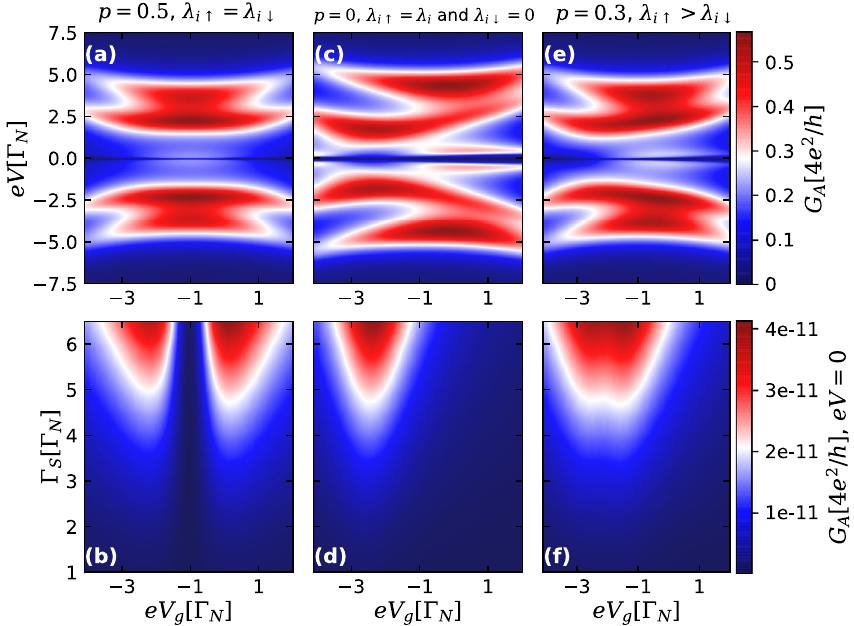
Figure 6. Upper panels: Color scale plots of the Andreev conductance G A [Eq. (5)] as a function of bias voltage 0.5 Ŵ , (cid:31) 2.0 Ŵ eV and QD gate voltage eV g , for the case of nonlocal MBSs ( (cid:31) R N L = N ) with small overlap = (cid:31) 3.0 Ŵ 0.5 , ( ε M R ) and Ŵ S = N . Panels ( a ), ( c ) and ( e ) correspond to the cases of spin-independent ( p = ≪ (cid:31) (cid:31) (cid:31) (cid:31) 0 , (cid:31) 0.3 , (cid:31) 0 ) and intermediate ( p > (cid:31) i ), fully spin-polarized ( p ) QD-TSC i i i i and i i = = ↑ = ↓ ↑ = ↓ = ↑ ↓ L , R . Lower panels: Color scale plots of Andreev conductance at zero-bias as a couplings, respectively, with i = function of the QD-S hybridization strength Ŵ S and eV g for same values of p as in the upper panels. Note that differently from the cases of nonoverlapping (Fig.2) and overlapping (Fig.4) MBSs well-localized at the edges of 0 ) drops to zero, and the isoconductance lines the TSC section, the value of the zero-bias conductance G A ( eV = are